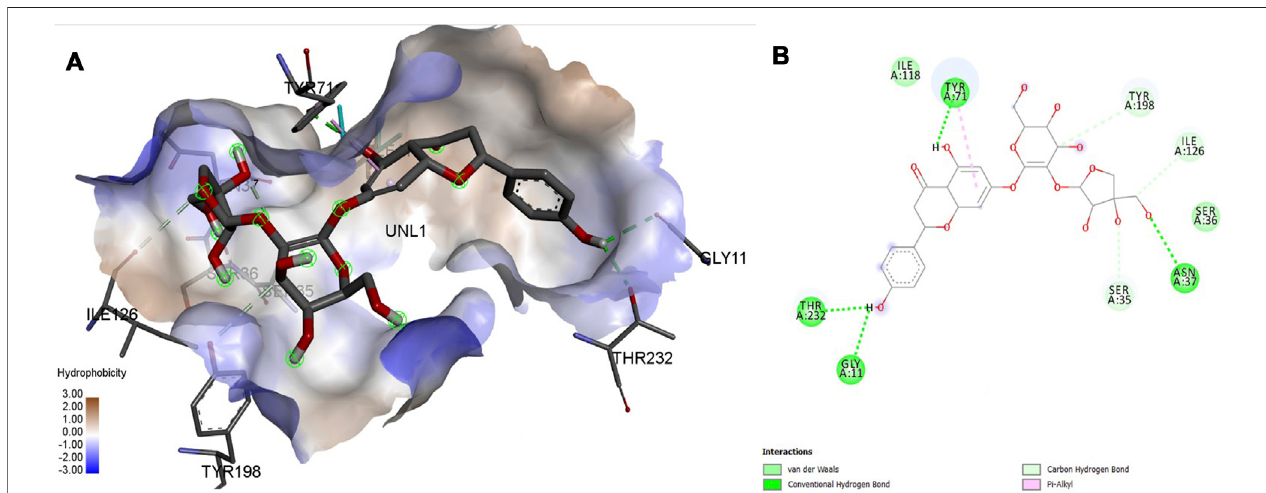
FIGURE 11 | Molecular docking interaction analysis of protein 4L7G, (A) : 3D interactions and (B) : 2D interactions have been represented between 4L7G-Apiin complex structures.